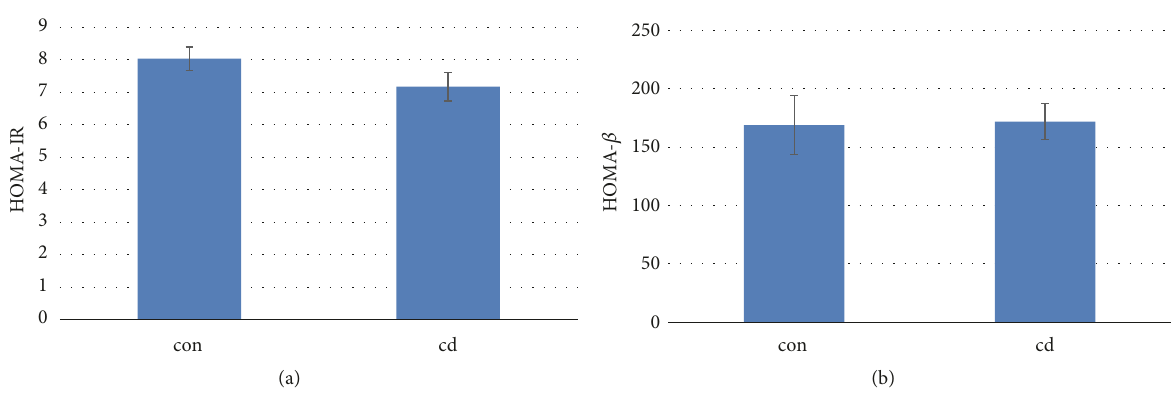
Figure 3: Effects of chronic Cd exposure on the insulin resistance ((a): HOMA-IR; (b): HOMA- 𝛽 ) in male C57BL/6 mice. Data are mean ± SEM